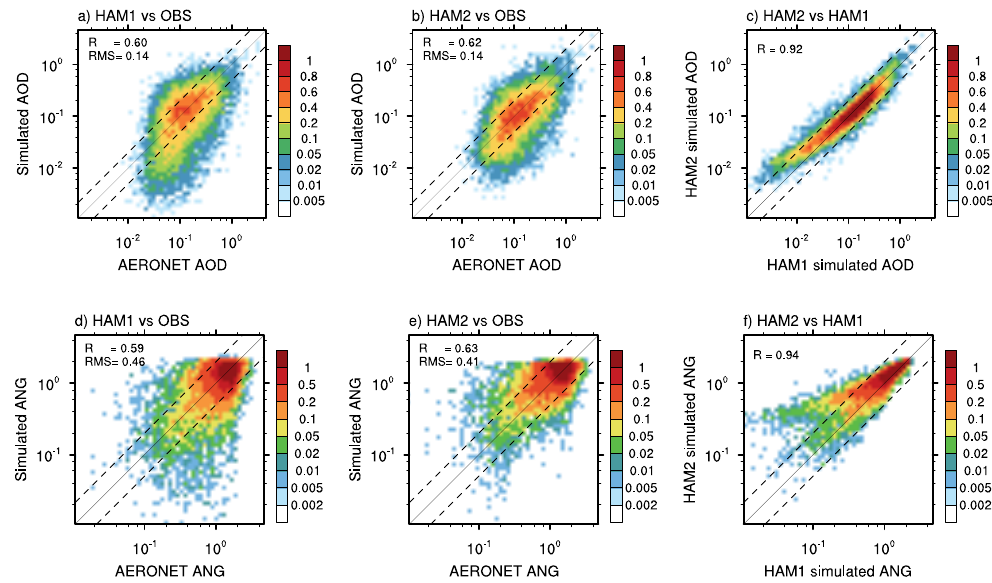
Fig. 21. Comparison of the AERONET-retrieved and model-simulated aerosol optical depth (upper row) and ˚Angstr¨om parameter (lower row). The color shading shows the joint probability density distribution (unit: %) as a function of, for example in (a) , the AERONET- retrieved and HAM1 simulated AOD, computed from the daily mean measurement retrieved from AERONET for the year 2000 at all locations indicated in Fig. 20 and model output (also daily means) sampled at the same time instances and locations. The R- and RMS-values noted in each panel are the correlation coefficient and root mean square difference of the two data series. Further details can be found in Sect.